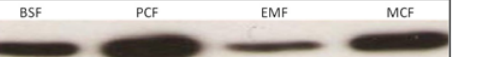
Fig 1. Immunoblot detection of antigen in the four major life cycle stages of T . congolense IL3000 using mAb Tc6/42.6.4. BSF: bloodstream forms; PCF: procyclic culture forms; EMF: epimastigote forms; MCF: metacyclic forms. Modified with permission from [1].